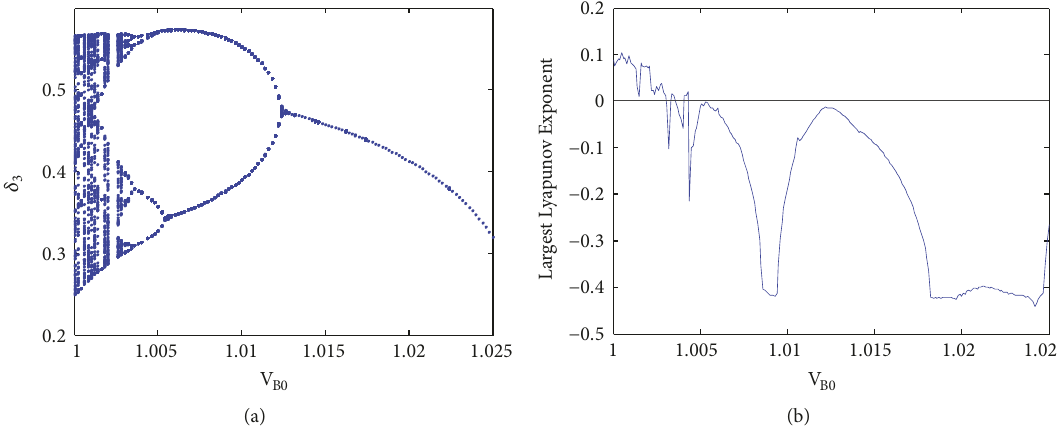
Figure 15: (a) Bifurcation diagram. (b) Largest Lyapunov